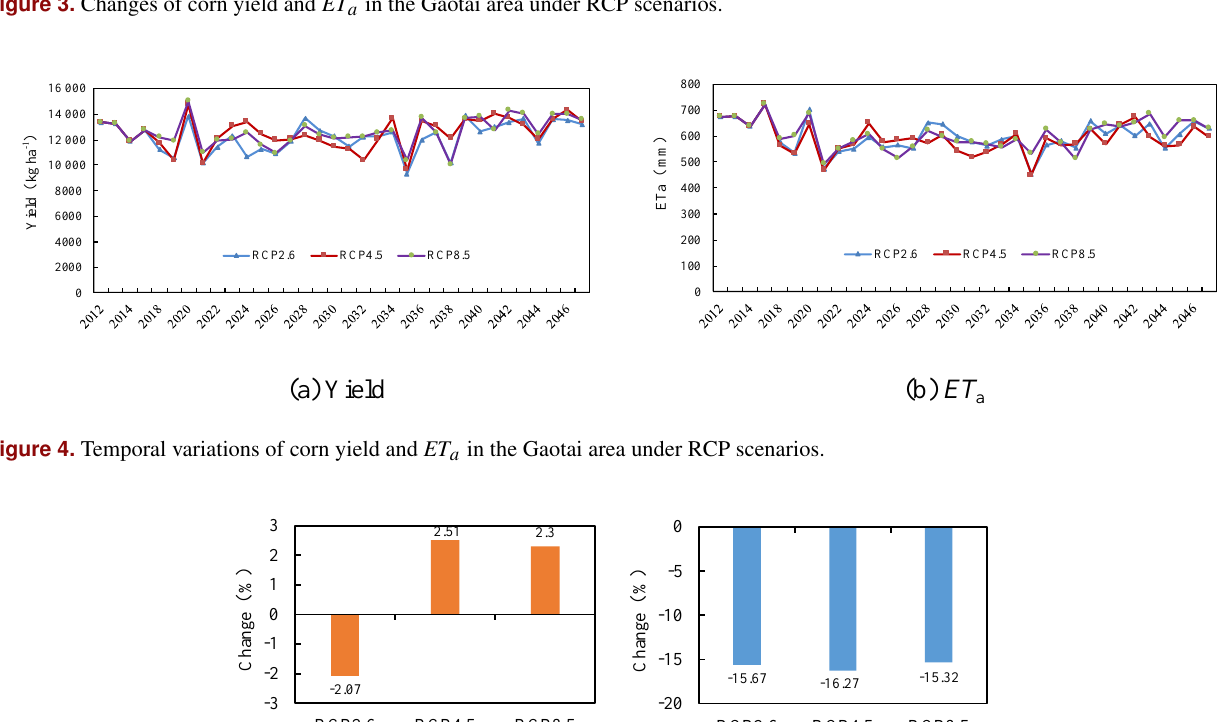
Figure 3. Changes of corn yield and ET a in the Gaotai area under RCP scenarios.